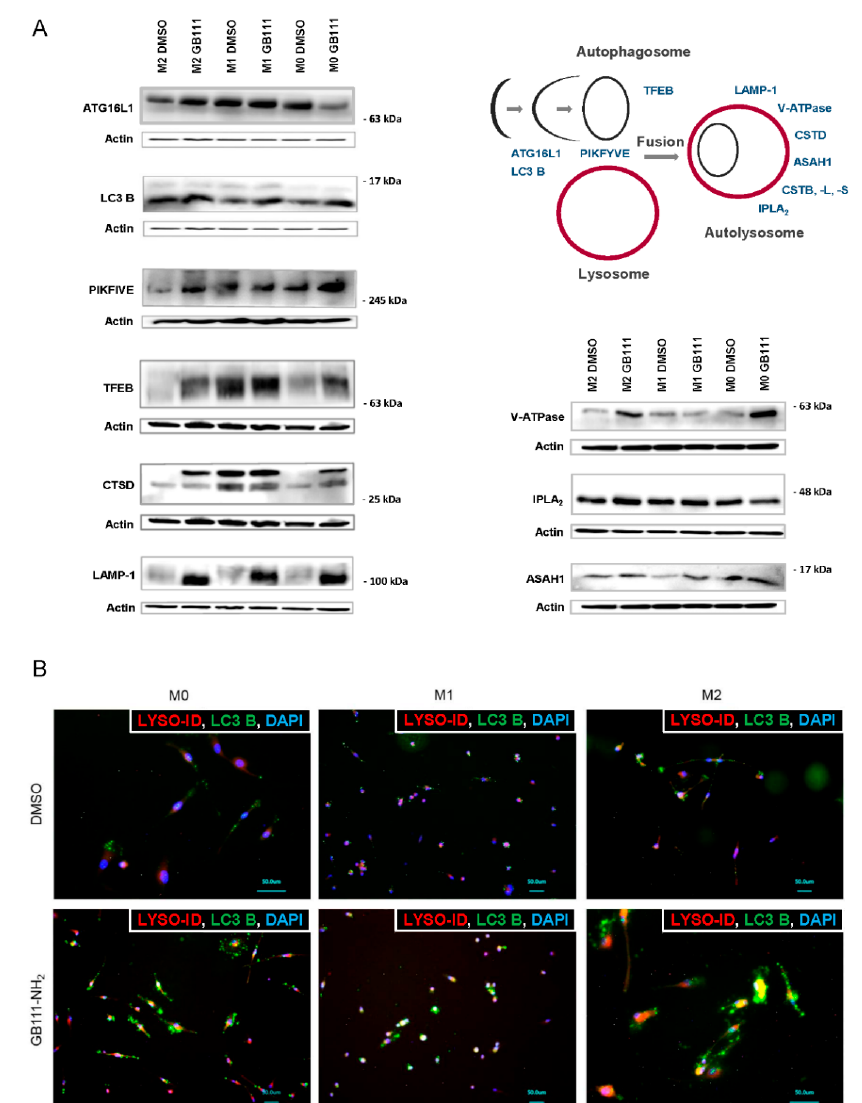
Figure 3. ( A ) Inhibition of cathepsin activity was accompanied by expression changes in typical autophagy- and lysosome-associated markers. The scheme illustrates the activity or localization of the analyzed markers. Human primary macrophages (M2, M1, and M0) were treated with GB111-NH 2 or DMSO as described. Representative immunoblots detecting ATG16L1, LC3B, PIKFYVE, TFEB, CTSD, LAMP-1, V-ATPase, lPLA 2 , and ASAH1 are shown. Data are representative for at least three independent experiments, and ß-actin served as loading control. ( B ) Representative immunofluorescence images of LC3B (green), lyso-ID (red), and DAPI (blue) in M0, M1, and M2 macrophages treated with inhibitor GB111-NH 2 or DMSO as described in the Methods section. The Lyso-ID ® Red Lysosomal Detection Kit (Enzo Life Sciences, Lörrach, Germany) was used for specific staining of lysosomes. The co-localization of autophagosome-associated LC3B and lyso-ID reflects the ability of the two organelles to fuse within the cells. DAPI (4 ′ ,6-Diamidin-2-phenylindol) was used for nuclear staining. Data are representative of at least three independent experiments. Scale bar is 50 µm.